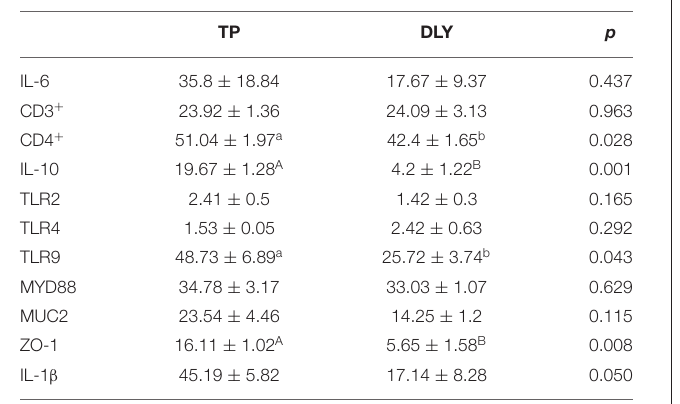
TABLE 3 | Comparison of jejunal mucosal immunity related indices of growing TP and DLY pigs.